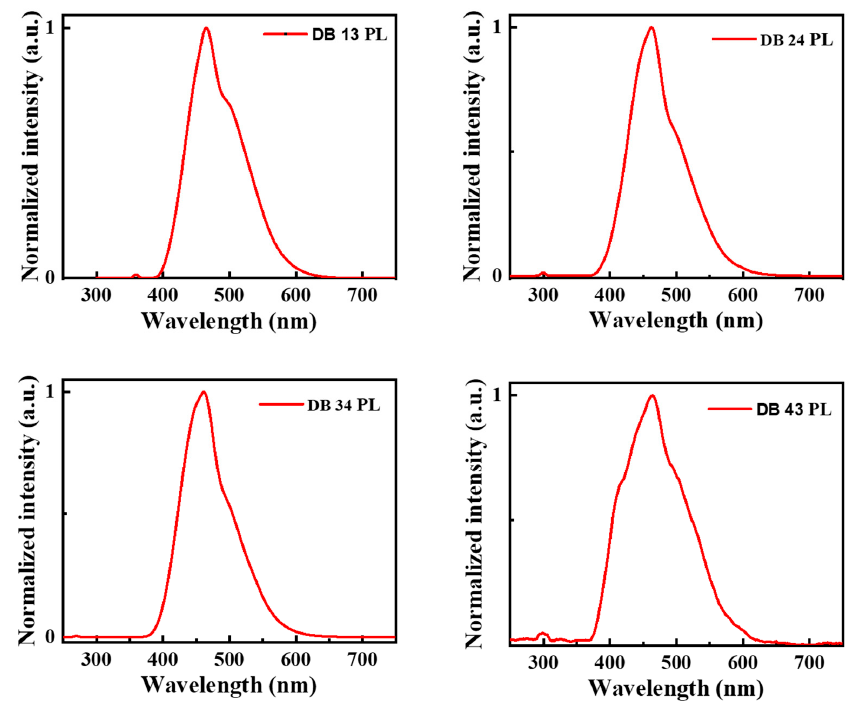
Figure 5. Photoluminescence (PL) spectra of the compounds DB13, DB24, DB34, and DB43.